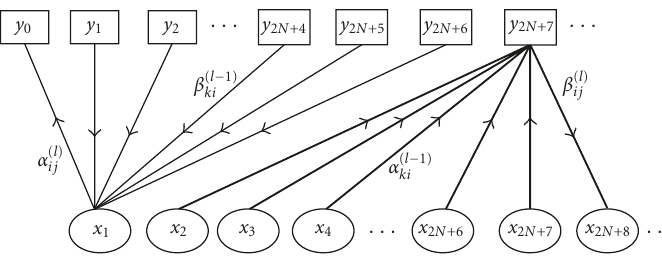
Figure 3: Diagram of the message-passing